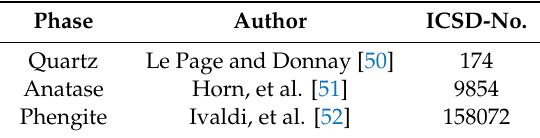
Table 2. Inorganic Crystal Structure Database ( ICSD) structure data for the Rietveld refinement. Phase